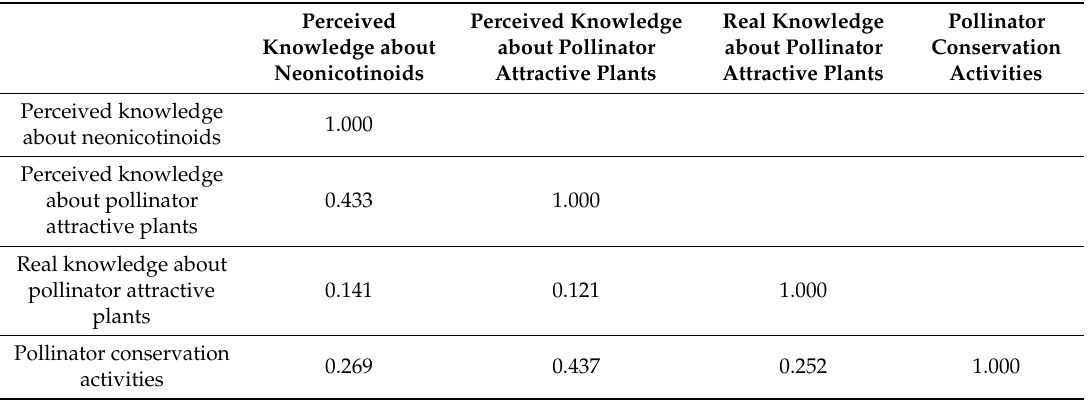
Table A1. Correlations among individual knowledge and involvement variables.